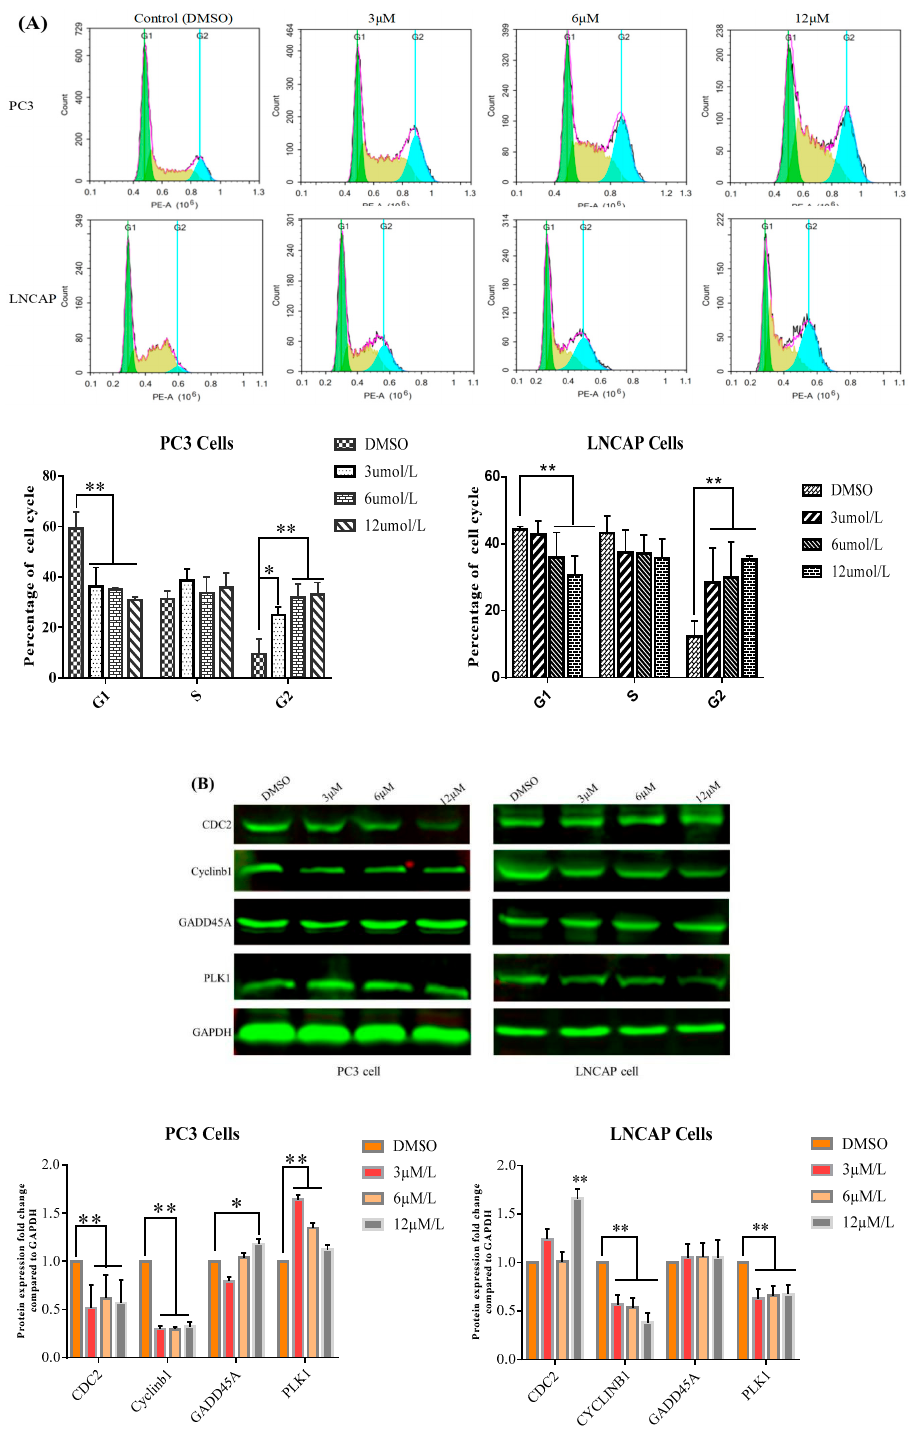
Figure 3. E ff ect of TC7 on cell cycle of PCa and LNCAP cells. Cells were treated with TC7 at di ff erent concentrations (3, 6, and 12 µ M) for 24 h. ( A ) E ff ect of TC7 on the cell cycle of PCa and LNCAP cells by flow cytometry. Cells were fixed and stained with propidium iodide (PI) to analyze the DNA content by flow cytometry. The bar graph shows PC3 and LNCAP cells percentage in di ff erent phases of the cell cycle. ( B ) TC7 e ff ect on the expression of proteins involved in the cell cycle of PCa and LNCAP cells by western blot and quantitatively analyzed by Image J software. Results are presented as mean ± SD from three independent experiments. * p < 0.05 ( n = 3); ** p < 0.01 ( n = 3), compared with the control